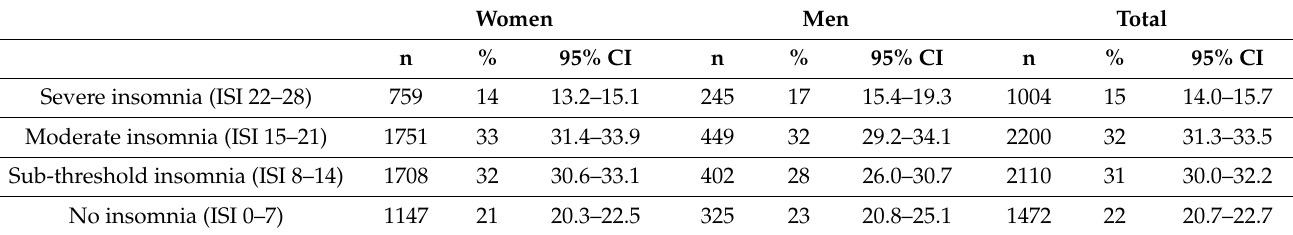
Table 4. Descriptive statistics on insomnia in the study group completed IPRP, classified into four categories according to the Insomnia Severity Index (ISI). Confidence intervals (CIs) were calculated with the Wilson